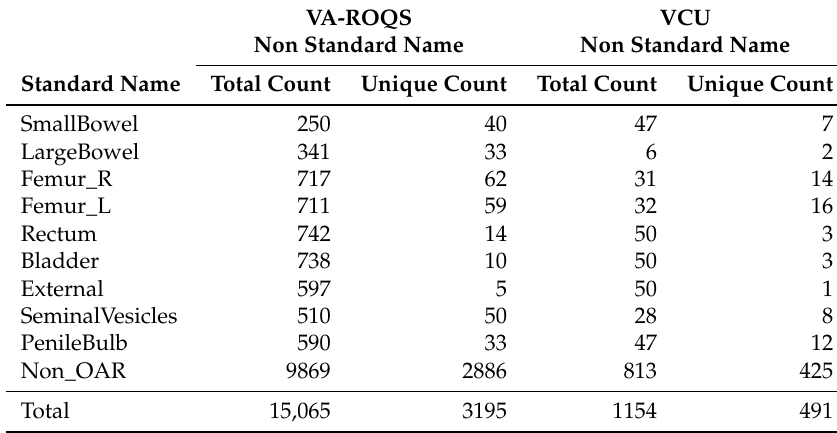
Table 2. Prostate structure type distribution in VA-ROQS and VCU datasets.